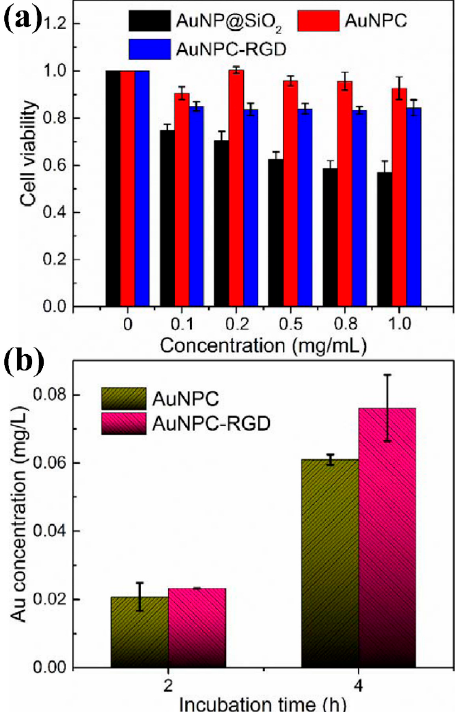
Figure 3. In vitro cytotoxicity and cellular uptake of different nanoparticles. ( a ) Viabilities of HeLa cells incubated with different nanoparticles; ( b ) Cellular uptake performance of AuNPC and AuNPC-RGD with incubation for 2 and 4